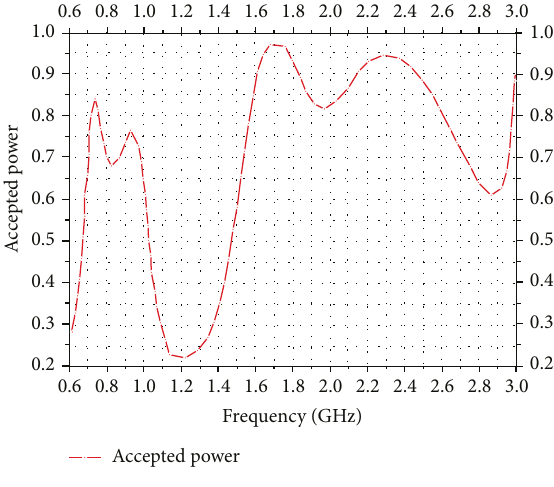
Figure 5: Radiation efficiency of the antenna.